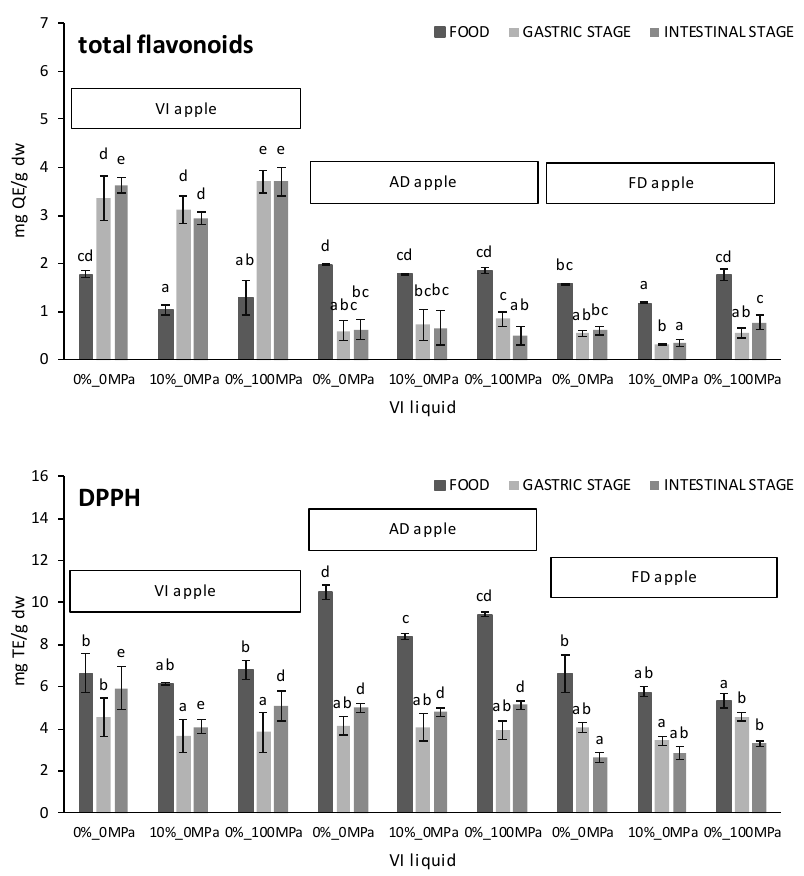
Figure 2. Antioxidant content at each stage of the gastrointestinal in vitro simulation (before digestion and after both the gastric and intestinal stages of digestion) as affected by the food matrix (VI, AD, and FD apples) and the vacuum impregnation liquid (0%_0MPa, 10%_0MPa, and 0%_100MPa). Error bars represent the standard deviation of triplicates from two independent treatments. a,b,c,d,e different letters within the same series indicate statistically significant differences ( p -value < 0.05) among samples analyzed at the same moment of the process.